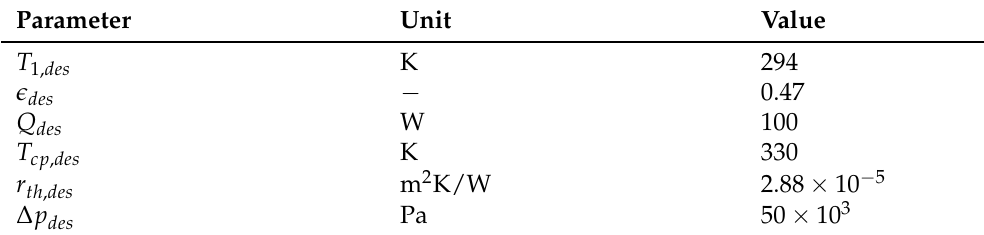
Table A3. Design inputs for coldplate